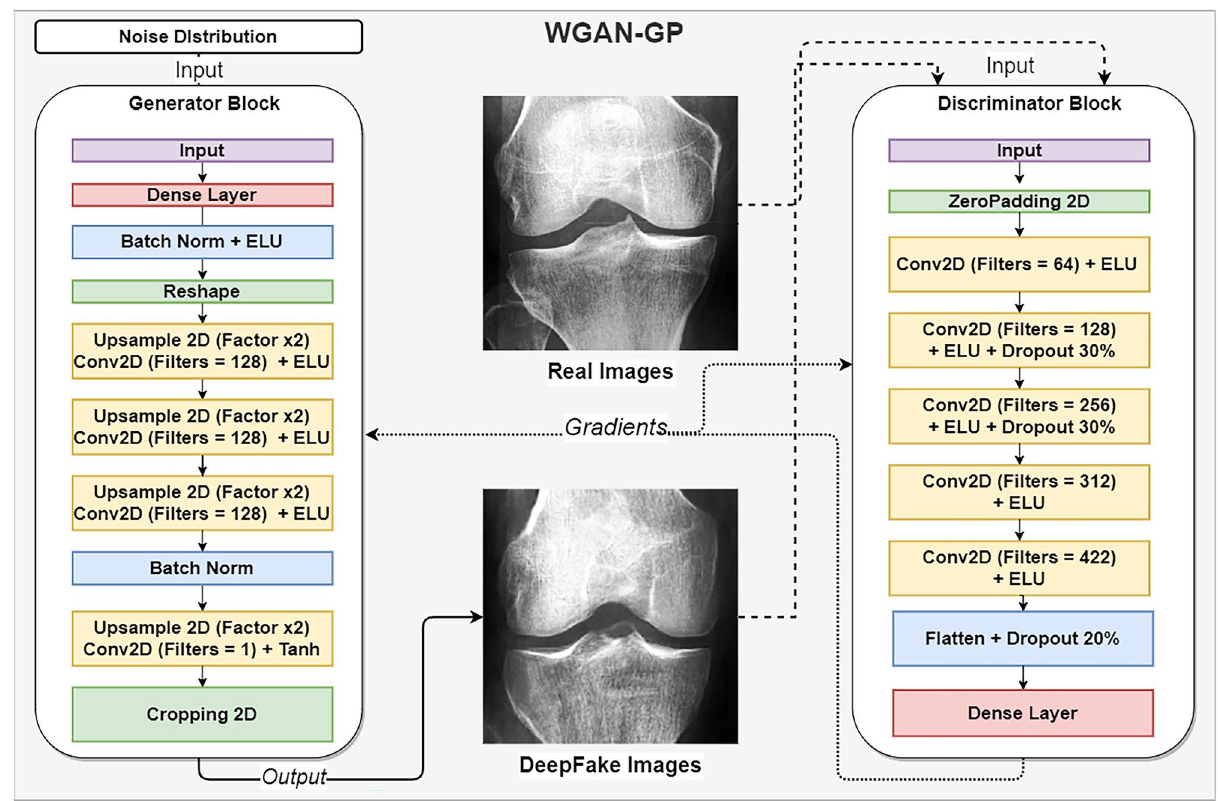
Figure 7. Architecture of the Wasserstein GAN used in these